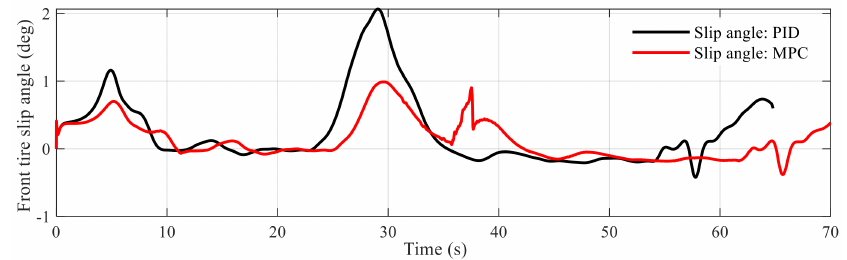
Figure 9. Front tire slip angle comparison of PID and MPC